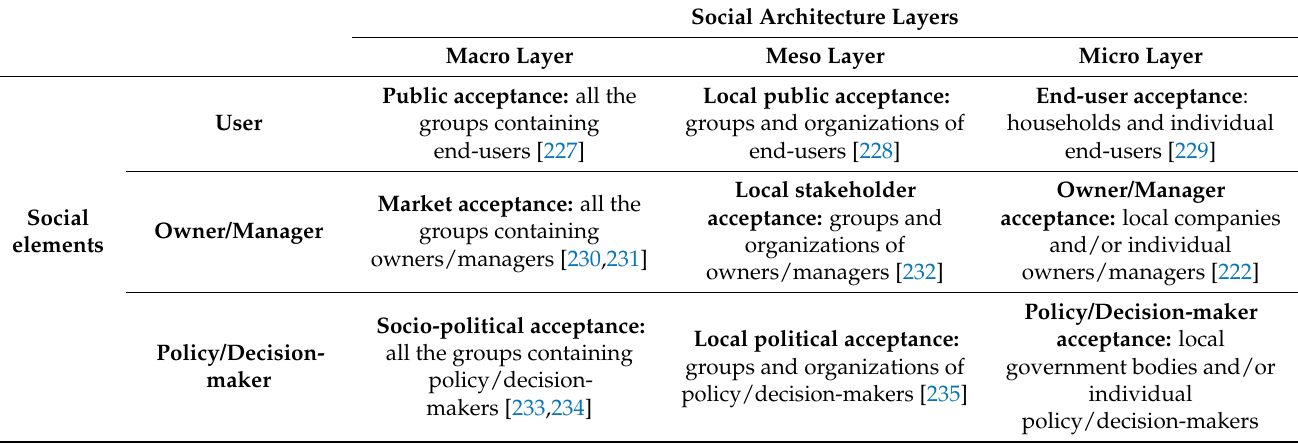
Table 9. Cross-analysis between social elements, social architecture, and their acceptance